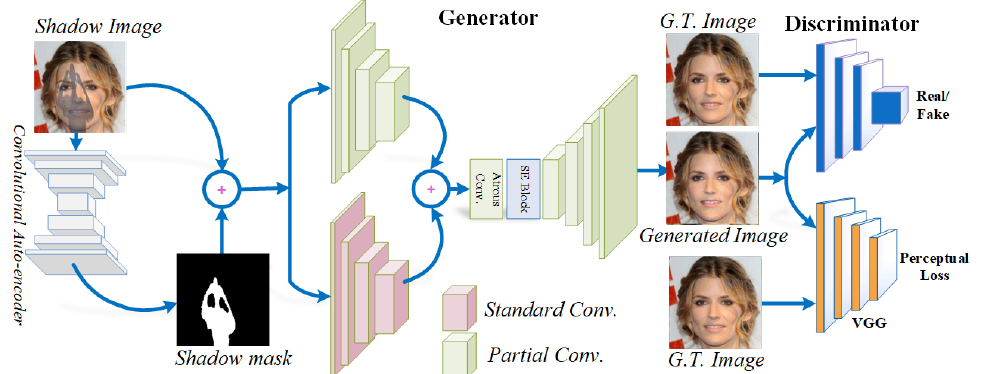
Figure 1. Proposed Network Architecture for Shadow